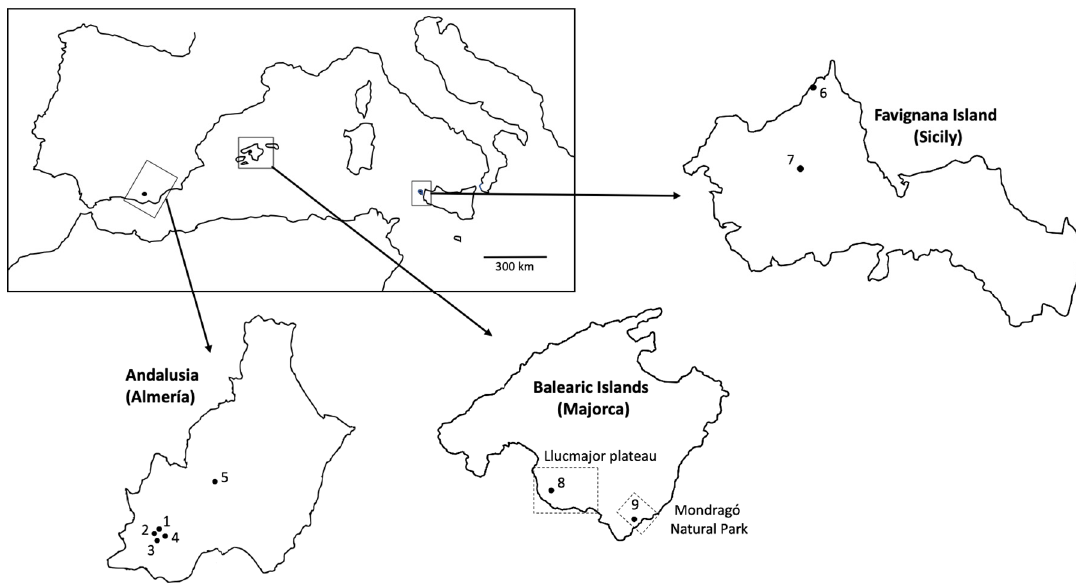
Figure 1. Location of the ponds referred to in this study. 1. Balsa Blanca; 2. Balsa de Caparidán; 3. Balsa del Sabinar; 4. Balsa de Barjalí; 5. Charca de Filabres; 6. Pozze dell’Ucceria; 7. Pozza di Grotta del Piano; 8. Marina de Llucmajor; 9. Mondragó Natural Park.